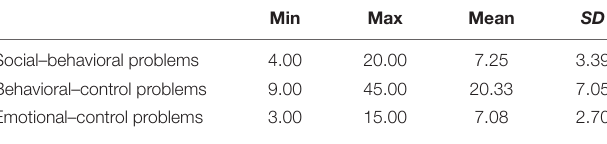
TABLE 4 | Descriptive data of the Prefrontal Symptoms